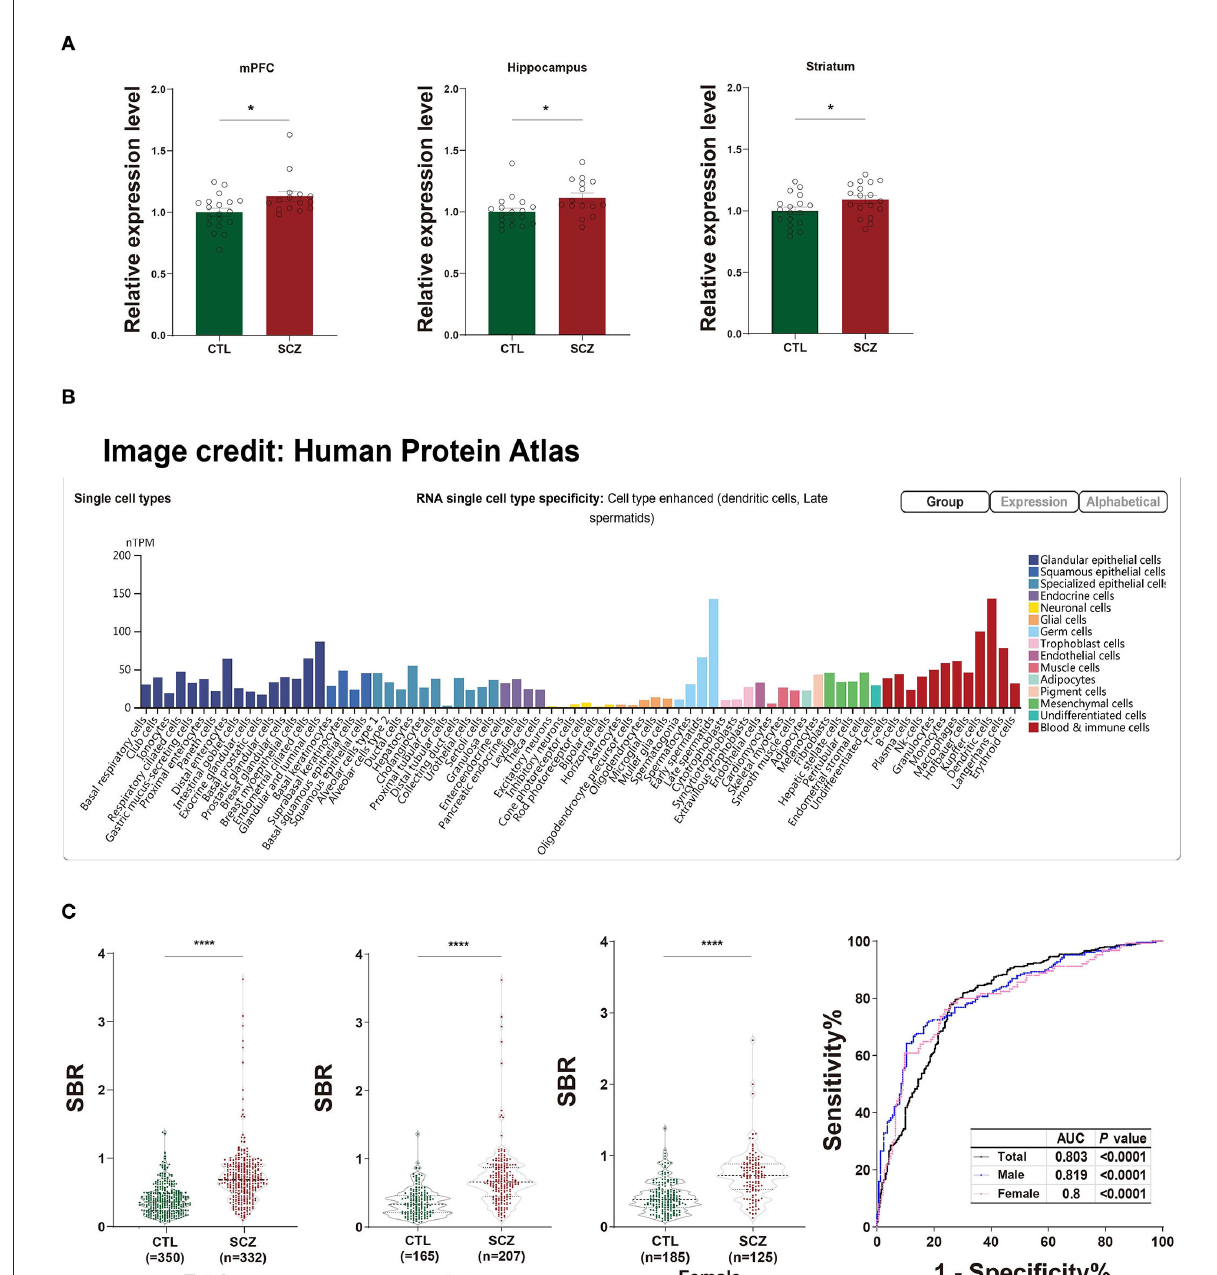
FIGURE1 Functional prediction of SFT2D2 . (A) The expression levels of SFT2D2 mRNA in the postmortem prefrontal cortex, hippocampus, and striatum of the human brain (18 SCZ vs. 15 CTL, from GSE53987 data set) (15). (B) SFT2D2 mRNA levels in single-cell sequencing across 76 cell types from Human Protein Atlas (https://www.proteinatlas.org/ENSG00000213064-SFT2D2/single$+$cell$+$type) (16). SFT2D2 displayed enhanced distribution in plasmacytoid dendritic cells (pDCs) and late spermatids. (C) Anti-SFT2D2 IgG levels in human plasma. Left: SBR values of anti-SFT2D2 IgG levels in combined subjects (350 CTL vs. 332 SCZ), male subjects (165 CTL vs. 207 SCZ), and female subjects (185 CTL vs. 125 SCZ). Right: Receiver operating characteristic curve (ROC) of anti-SFT2D2 IgG assay. Data are expressed as mean ± standard error of the mean (SEM) and individual scatter plots are shown. CTL, control; SCZ, schizophrenia; SBR, specific binding ratio; AUC, area under the ROC